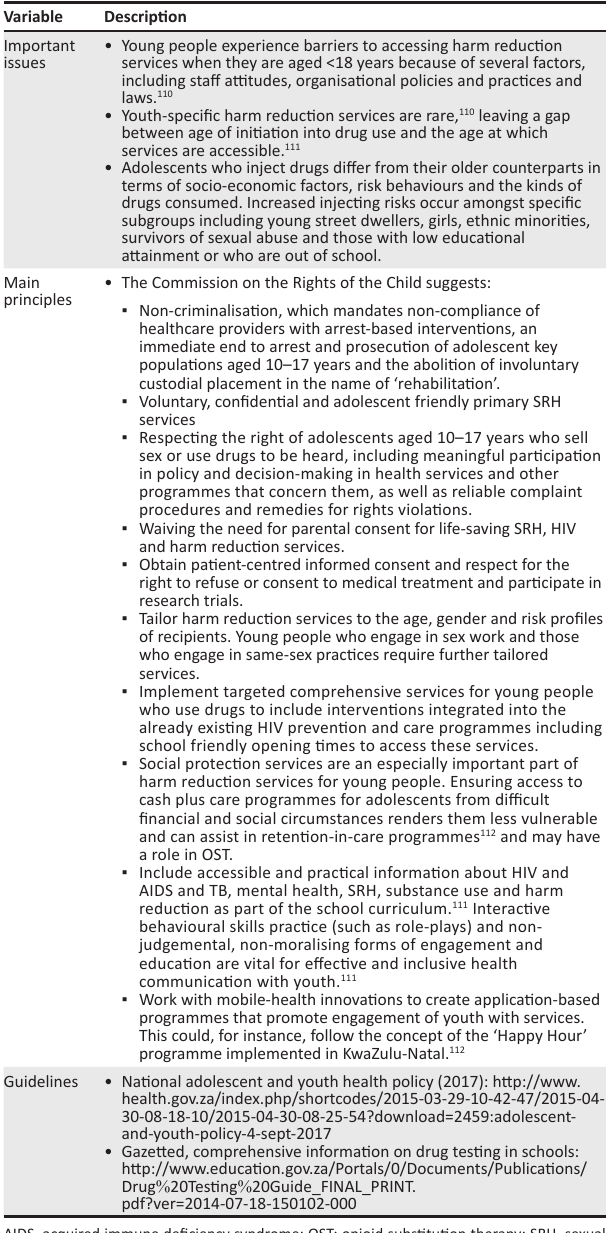
TABLE 25: Young people who use